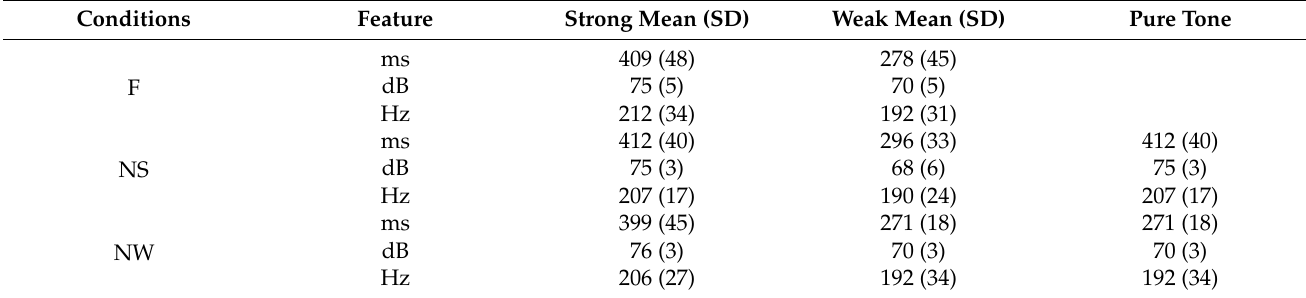
Table 3. Mean (and standard deviation) of the duration (ms), decibels (dB), and frequency (Hz) of strong syllables (S), weak syllables (W), and pure tones (PT) by the test